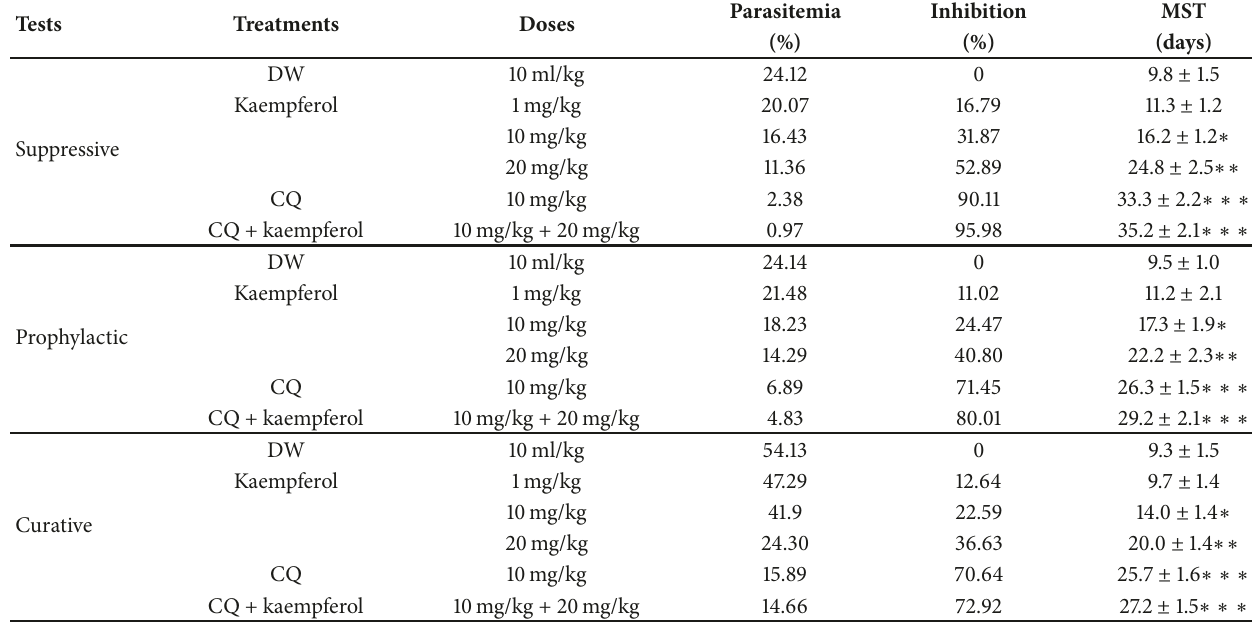
Table 2: Effect of kaempferol on MST of PbANKA infected mice in suppressive, prophylactic, and curative